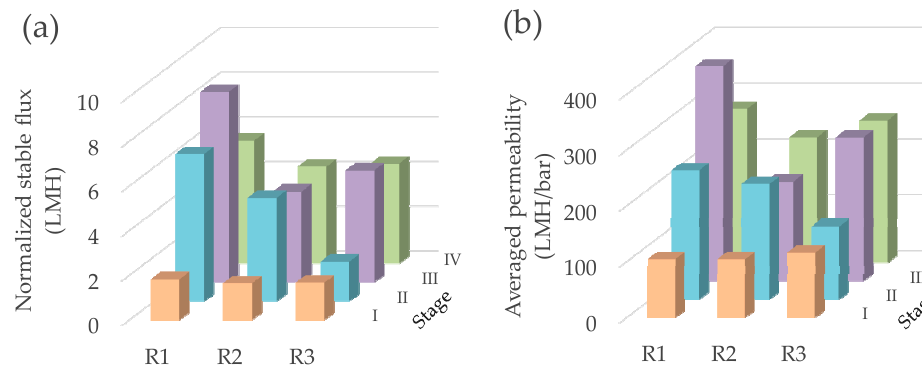
Figure 4. ( a ) The normalized stable flux and ( b ) averaged permeability in the GDM reactors. In the GDM systems, it is noted that the cake layers formed on the membrane surface were associated with microbial community development and biopolymer accumulation [7]. On the other hand, the submerged flat sheet organic membrane modules were limited by pressurized physical backwashing. Thus, periodical chemical cleaning (30–60 min per 3–4 days) was employed for the GDM reactors, aiming to inhibit the develop- ment of biofouling on the membrane (in R1 and R2, the chemical solution in the permeate for soaking membrane; in R3, chemical solution flushing the membrane surface). Clearly, recovery ratios are associated with cleaning modes and duration (Figure 5).